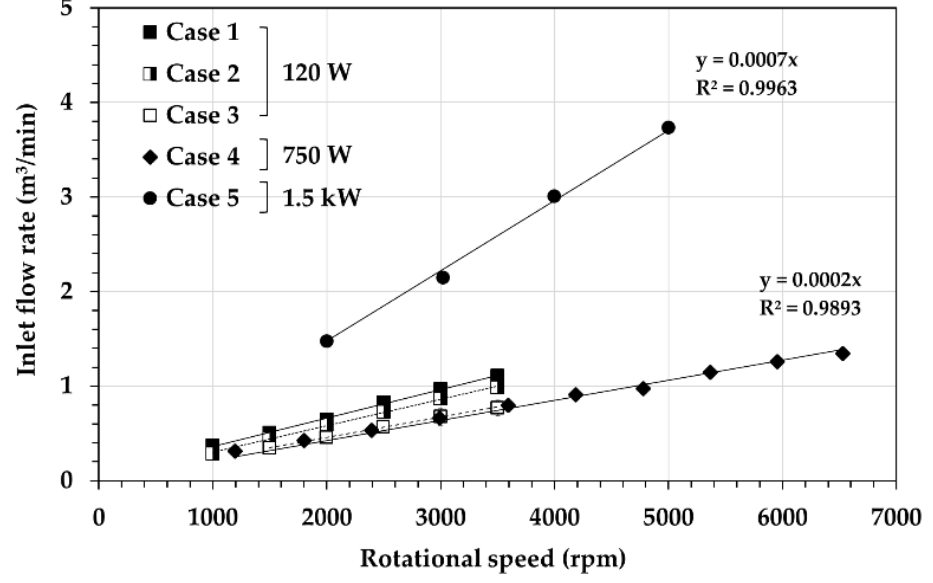
Figure 4. Separator flow rate with changes in disk shape and rpm.